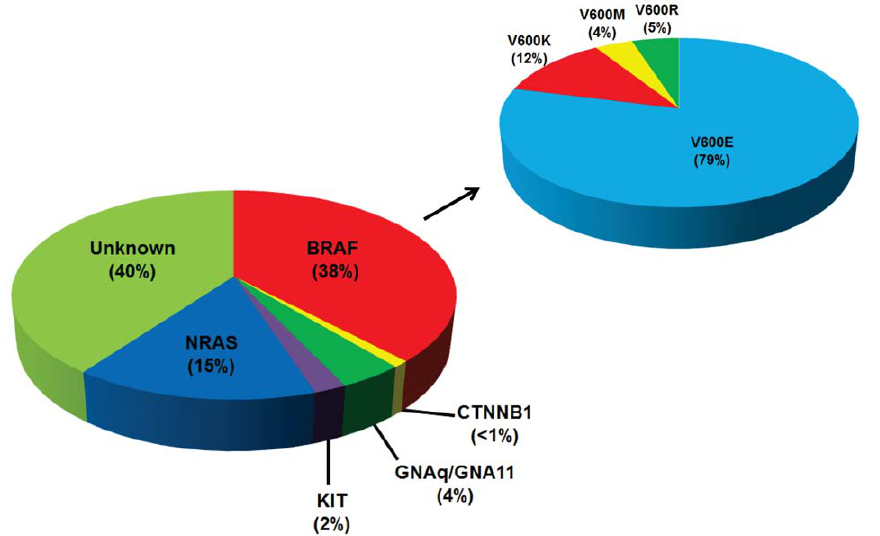
Figure 2. Distribution of mutations in the first 150 tumors genotyped in the molecular diagnostic lab. Left: distribution of all mutations. Right: distribution of V600 mutations. See Table S10 for more details.